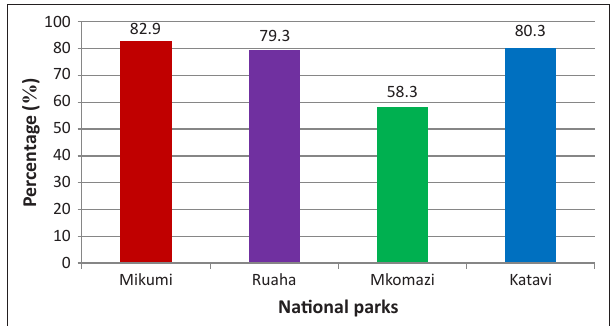
FIGURE 3: FMDV infection status in cattle herds surrounding four Tanzanian national parks. TABLE 1: Results for NSP ELISA test using PrioCHECK® FMDV NS Kit. Location Animal species Samples tested